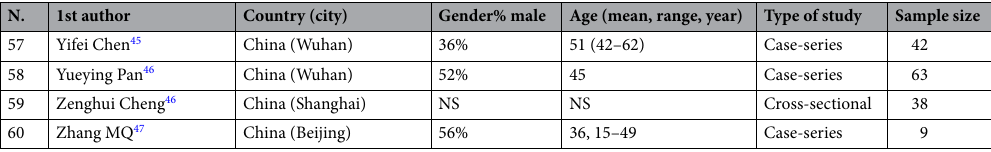
Table 1. Data of 60 included studies in the data extraction step. NS not